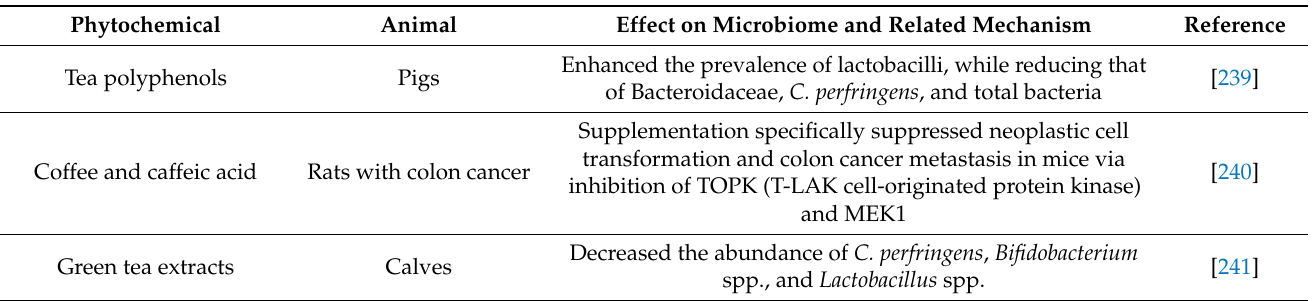
Table 1. Studies carried out in animals to evaluate the impacts of phytochemicals on the alteration in the gut microbiome. Phytochemical Animal Effect on Microbiome and Related Mechanism Reference Pigs Supplementation specifically suppressed neoplastic cell transformation and colon cancer metastasis in mice via Rats with colon cancer